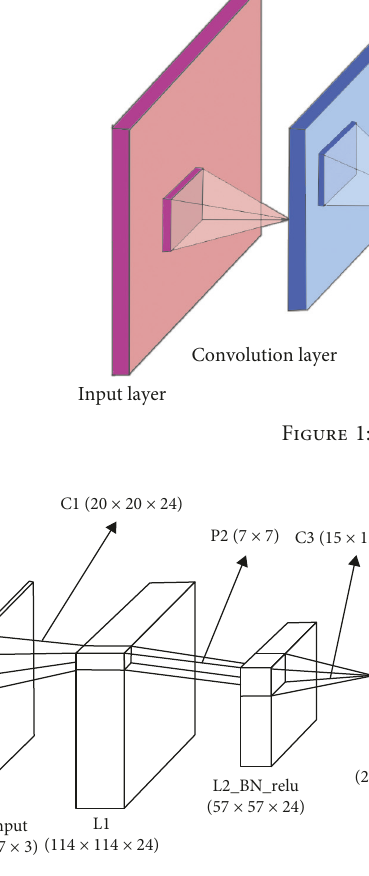
Figure 2: Network structure.